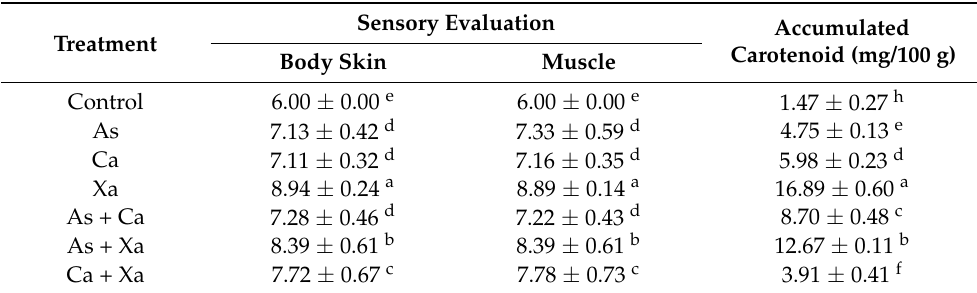
Table 4. Sensory evaluation and accumulated carotenoids in the muscle of fish fed various pigments diets after 6 weeks.